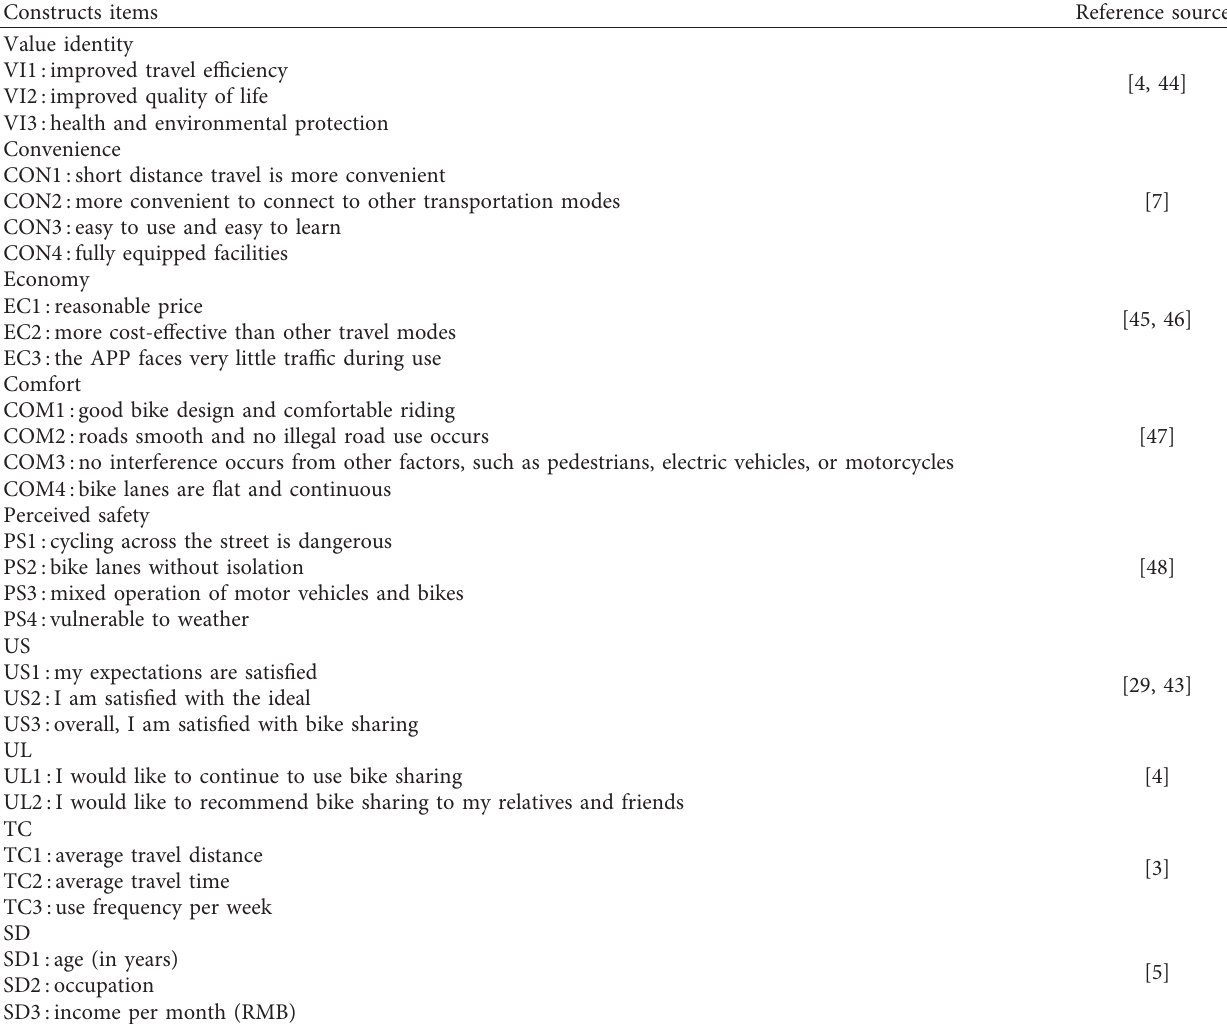
Table 2: Interpretation of variables included in the